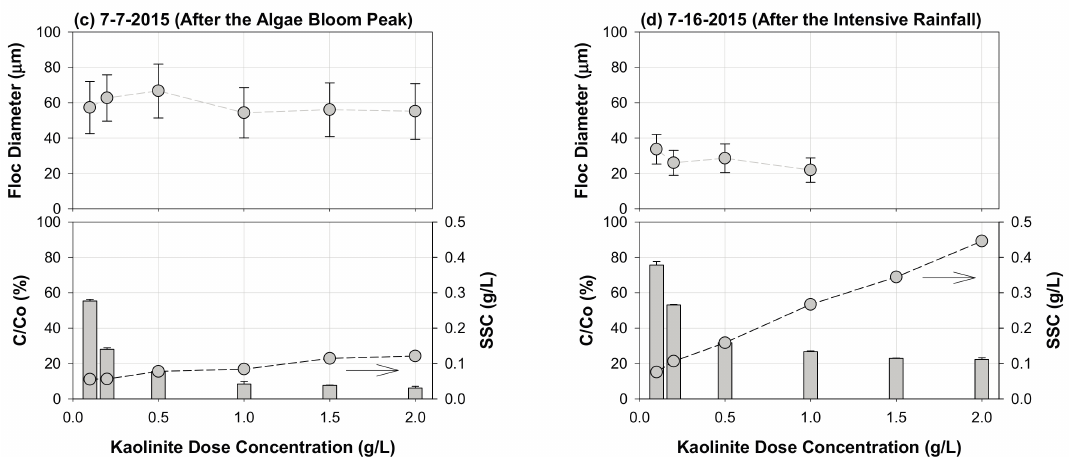
Figure 7. Typical results from the flocculation potential tests, measured ( a ) before the algal bloom on 5 June 2015; ( b ) at the peak of algal bloom on 24 June 2015; ( c ) after the peak of algal bloom on 7 July 2015; and ( d ) after the heavy rainfall on 16 July 2015.